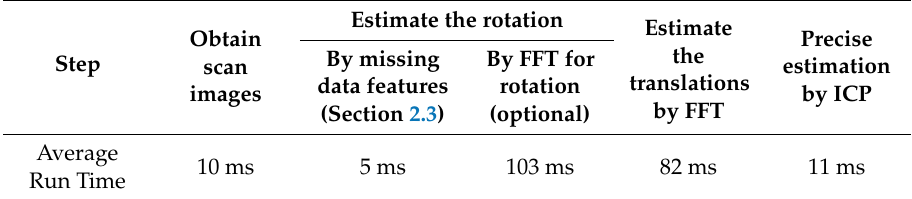
Table 3. Average run-time for each step of FFT-ICP2.